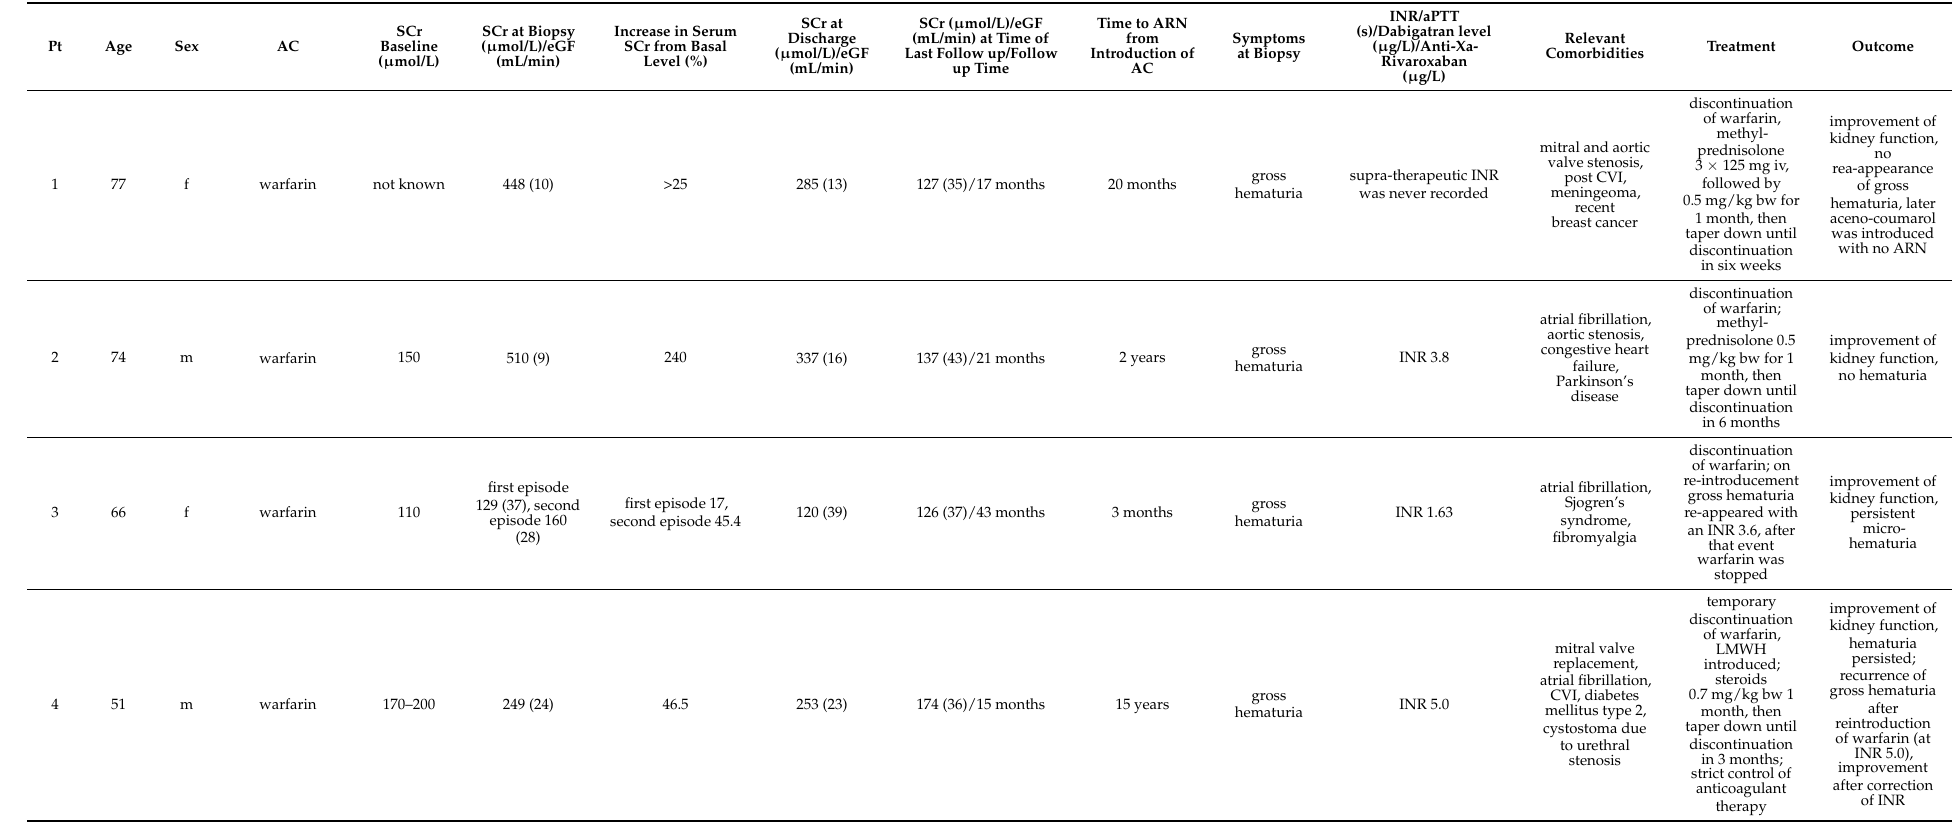
Table 2. Clinical and demographic data in a Slovenian cohort of patients with anticoagulant-related